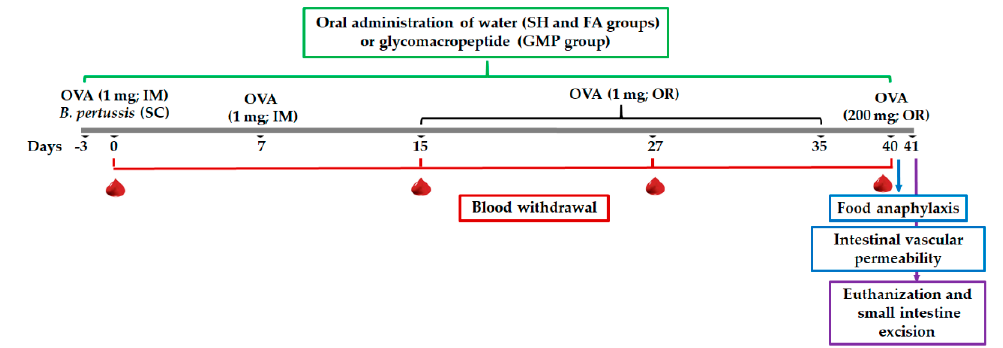
Figure 2. Schematic diagram of experimental setup and glycomacropeptide (GMP) administration. FA protocol was developed in rats by intramuscular (IM) sensitization and oral (OR) challenge with ovalbumin (OVA). SC, subcutaneous; SH, sham control group; FA, FA-induced group; GMP, FA-induced and GMP-treated group.